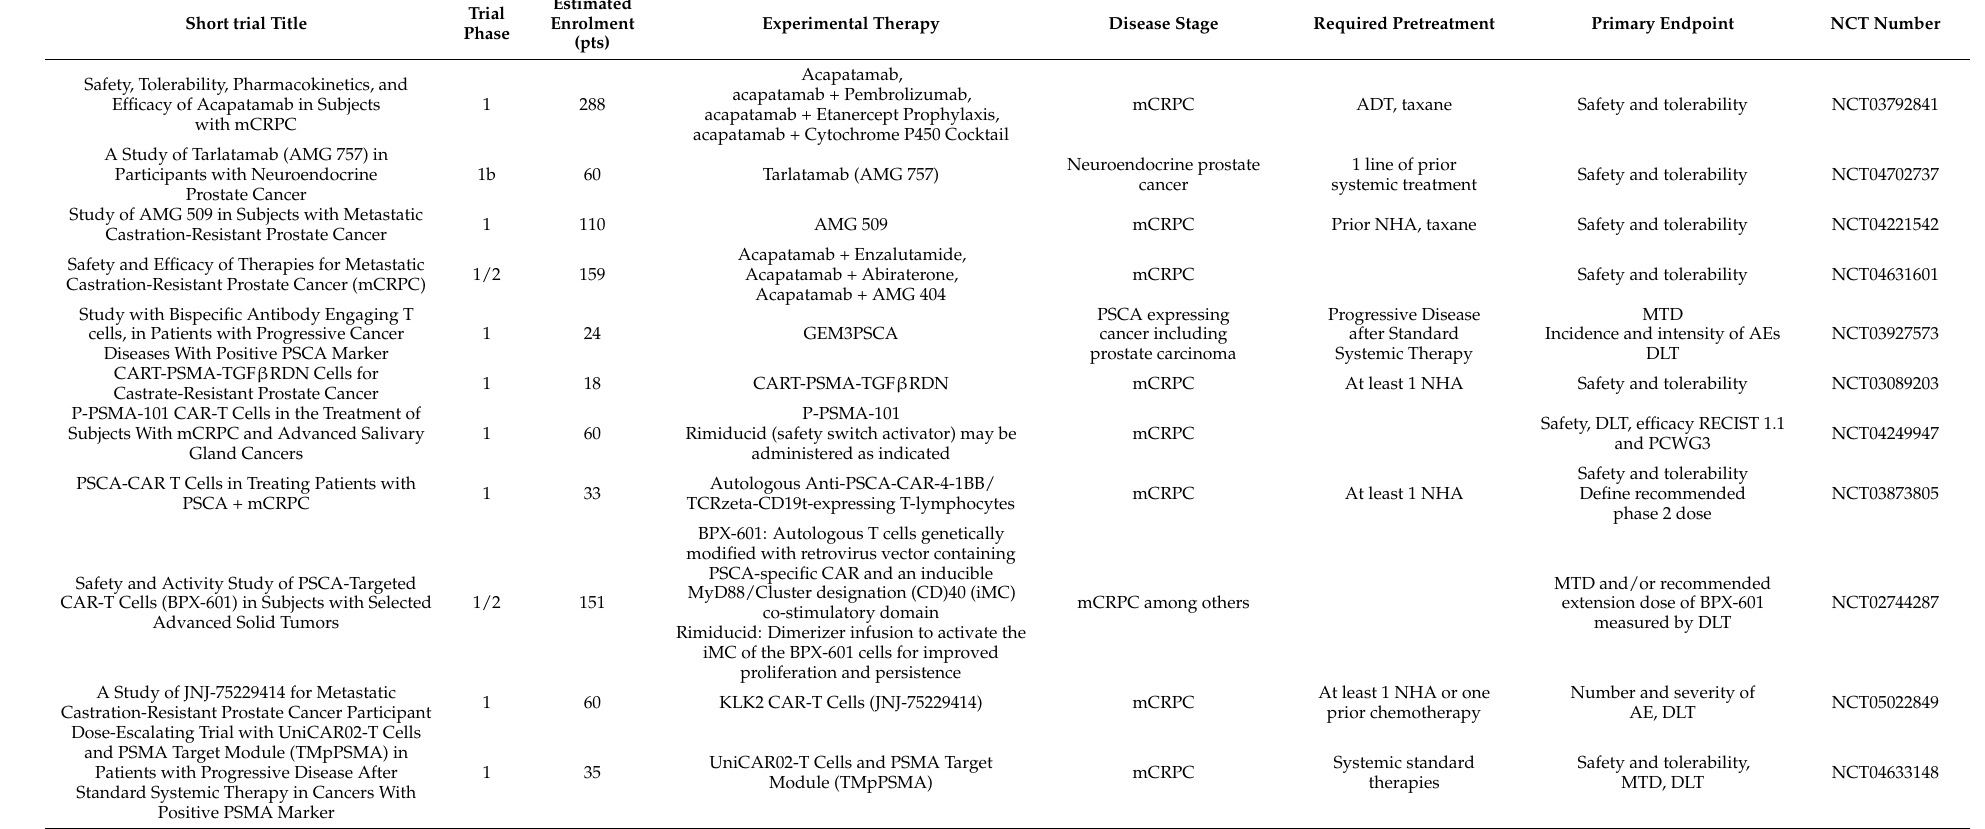
Table 3. Active trials with bispecific T cell engagers (BiTEs) and CAR-T cells in advanced